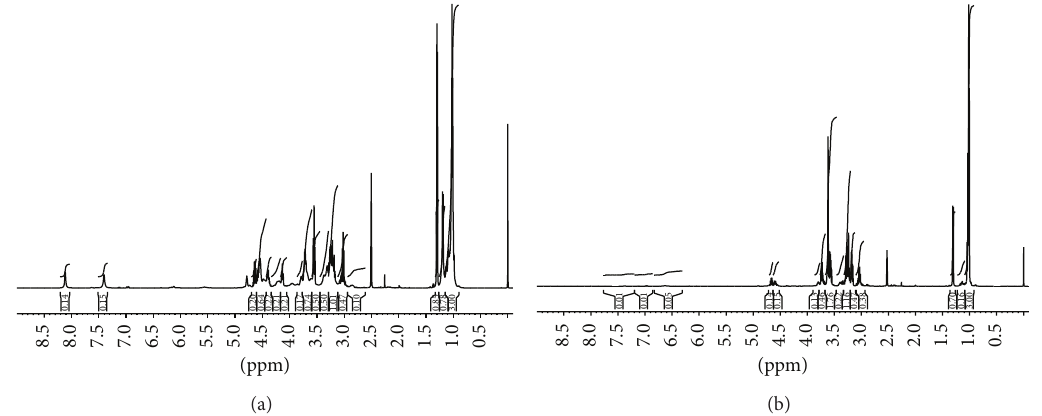
Figure 5: 1 H-NMR spectrum of product obtained at the initial molar ratio of EBUII: PC 1 :6 in the presence of 0.12 mole K 2 CO 3 /mole EBU at temperature 180 ∘ C: (a) without D 2 O and (b) with D 2 O addition.